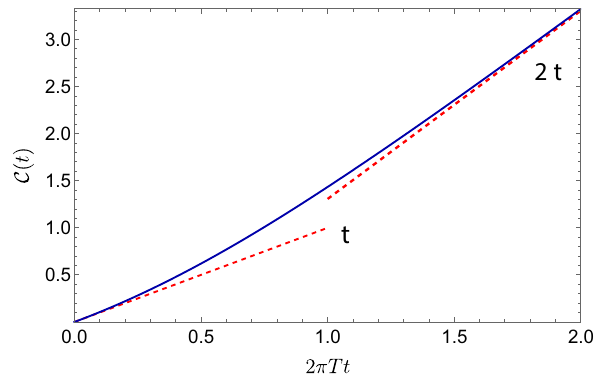
Fig. 21 Complexity growth calculated in the epidemic model with an insertion of a heavy operator of size N 0 = N / 2